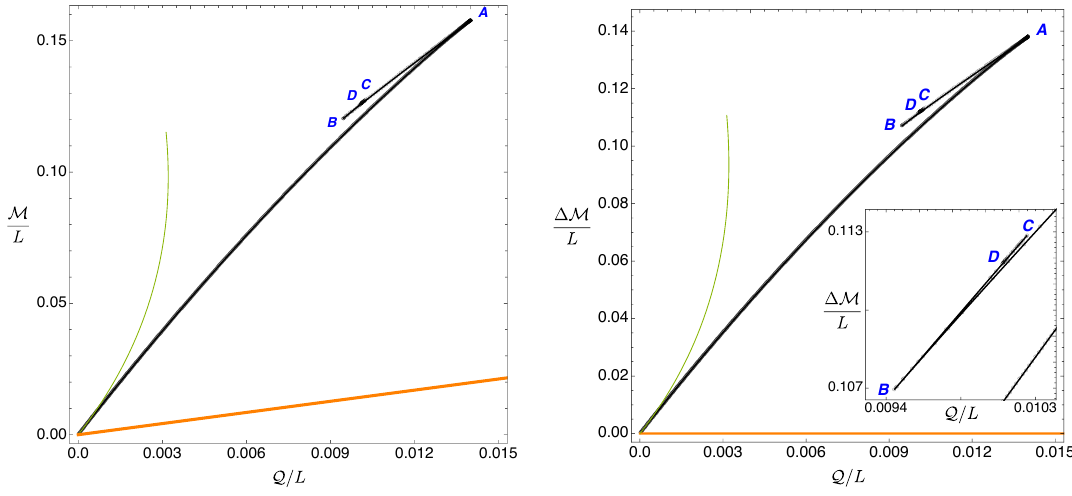
Figure 3 . Main soliton family with e = 0 . 23 ( e < e γ ). The orange curve describes the extremal RN BH solution, and the green curve is the perturbative prediction of [4]. Left panel: quasilocal mass M /L as a function of the quasilocal charge Q /L . Right panel: ∆ M is the mass difference between the soliton and an extremal RN BH that has the same quasilocal charge. For larger e this quantity will distinguish better some solitons from the extremal RN BH solution. The inset